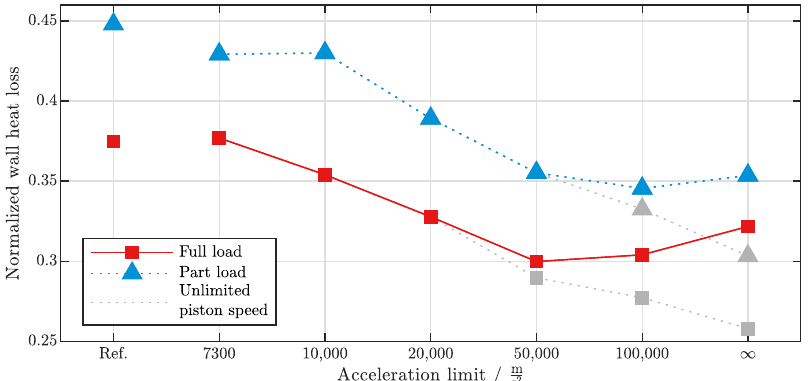
Figure 14. Evolution of the normalized wall heat losses for full and part load operation as a function of maximum piston acceleration